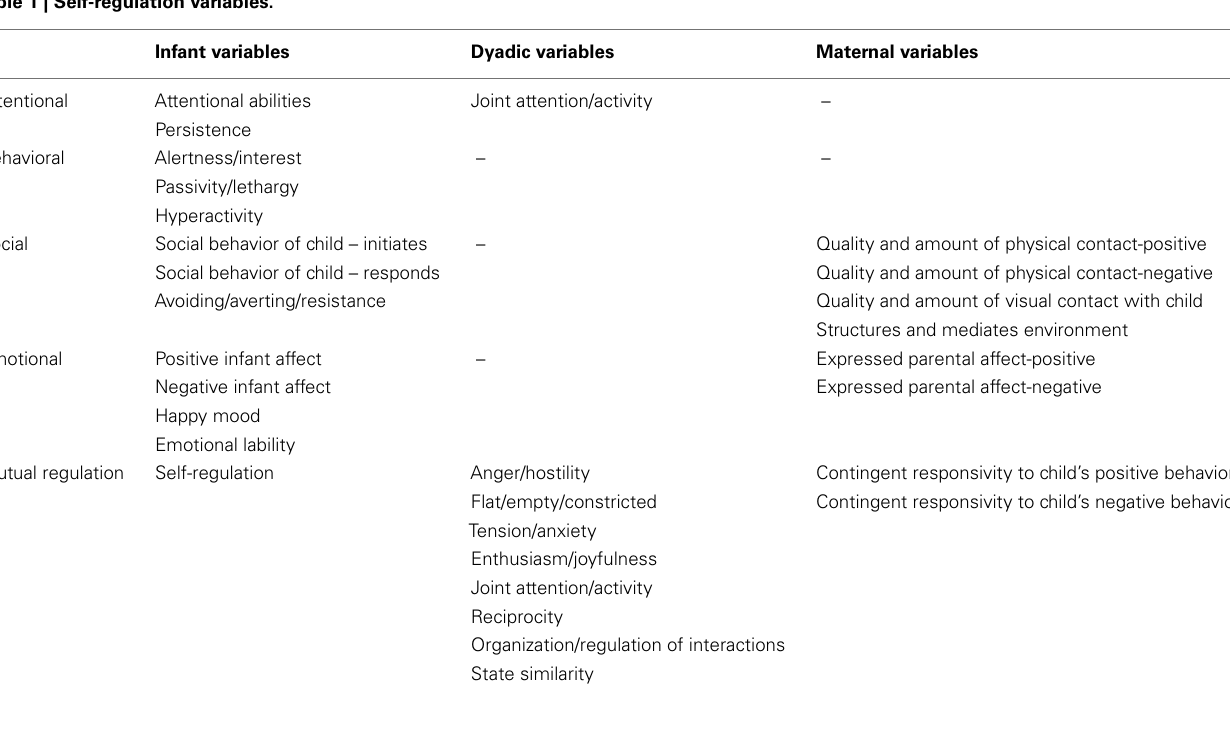
Table 1 | Self-regulation